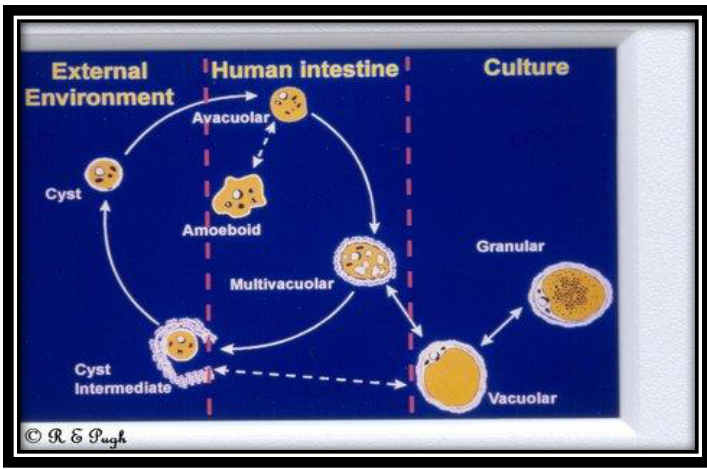
Figure (2): Life cycle of Blastocystis hominis